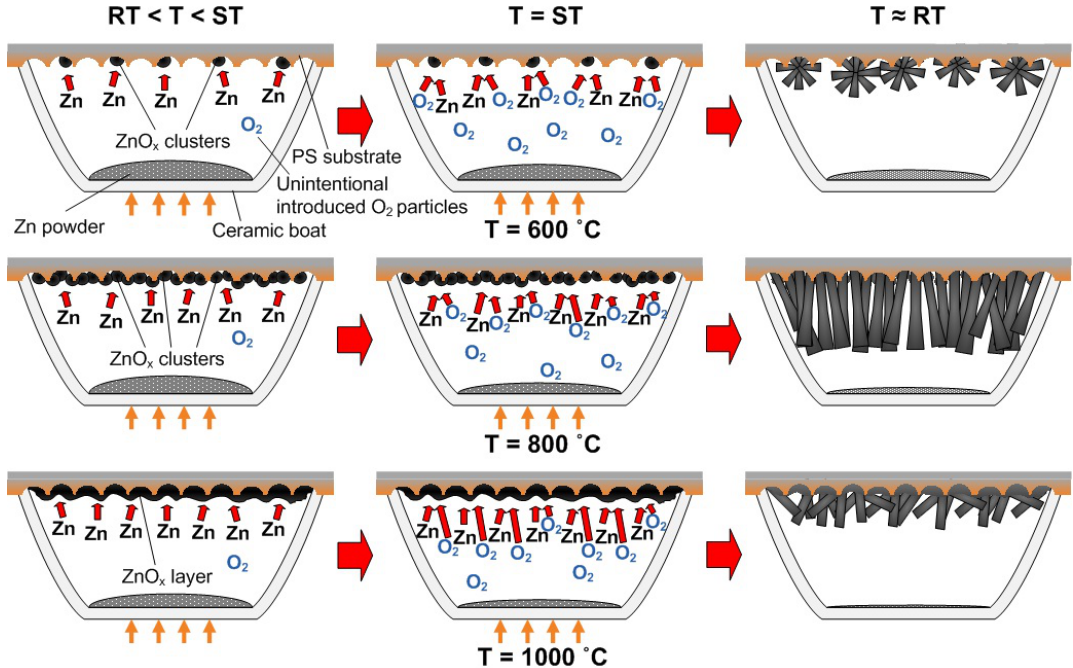
Figure 9. A schematic of the growth